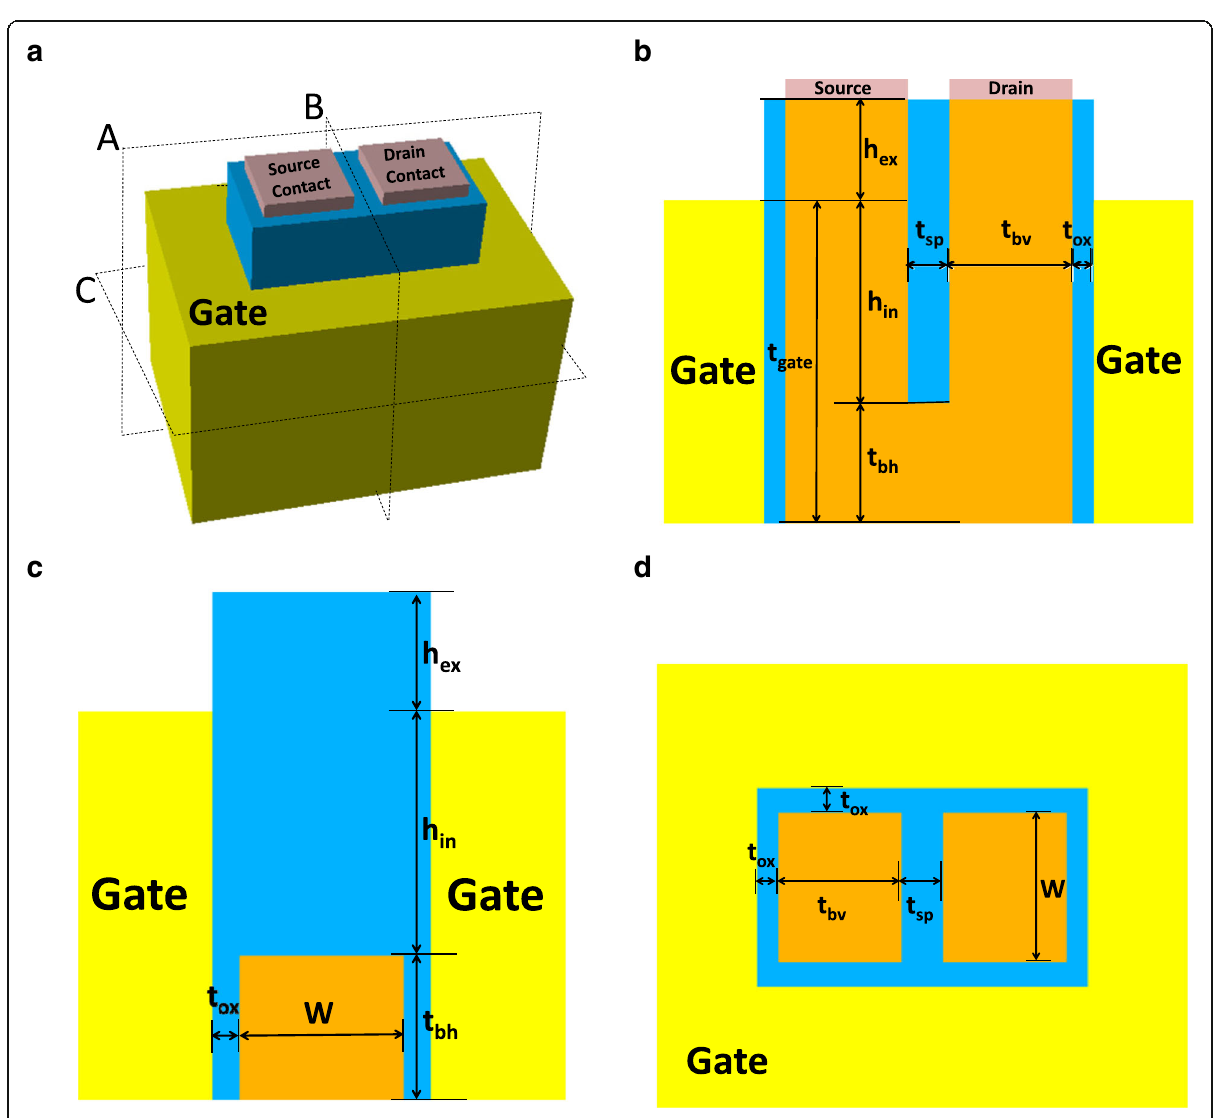
Fig. 1 a 3D schematic view of the RGUC FET. b Profiles of the device cut through plane A of a . c Profiles of the device cut through plane B of a . d Profiles of the device cut through plane C of